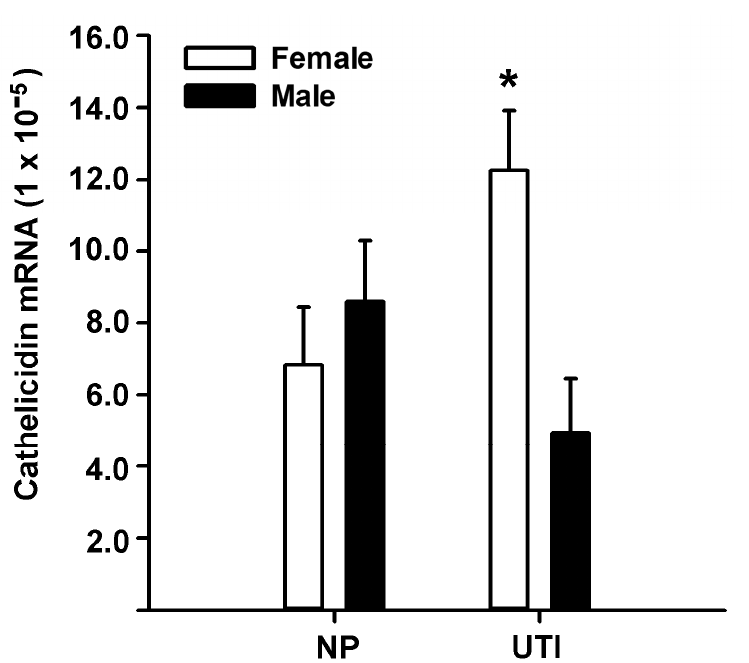
Figure 2. Tissue cathelicidin gene expression in placentas from normal and UTI-affected pregnancies. The relative gene expression of cathelicidin was analyzed by qPCR in placentas obtained from normal pregnancies (NP) and with urinary tract infection (UTI) and was normalized against GAPDH gene expression. Bars represent least-square means ± SEM. * p < 0.03 vs. NP subgroups and vs. UTI-male subgroup.